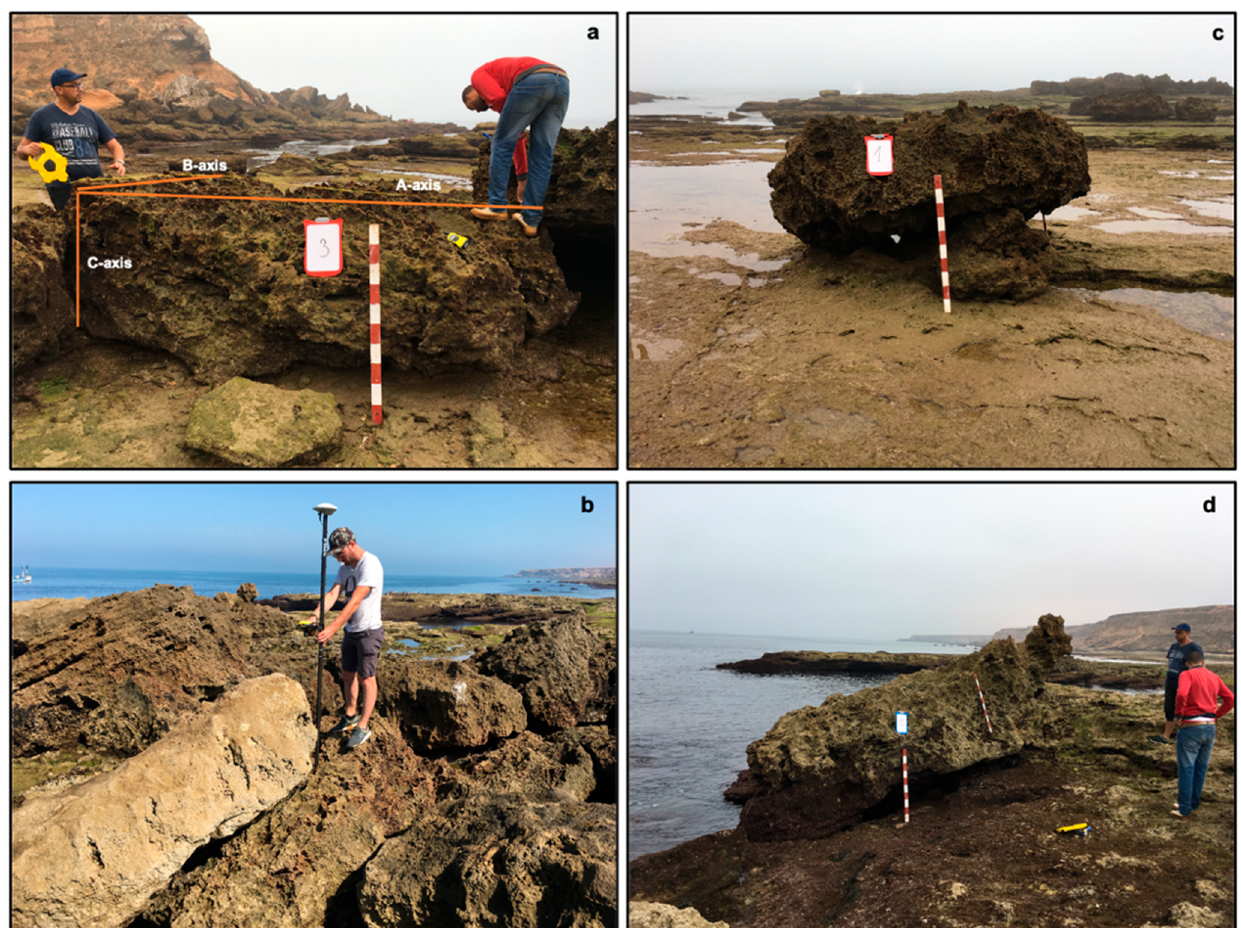
Figure 4. Examples of boulders at Laghdira: ( a ) measured boulder axes (A, B, and C); ( b ) DGPS topographic measurements of boulder positions; ( c ) imbricated boulders at the upper part of the rocky platform (B1); ( d ) joint-bounded boulder at the platform edge (B11).